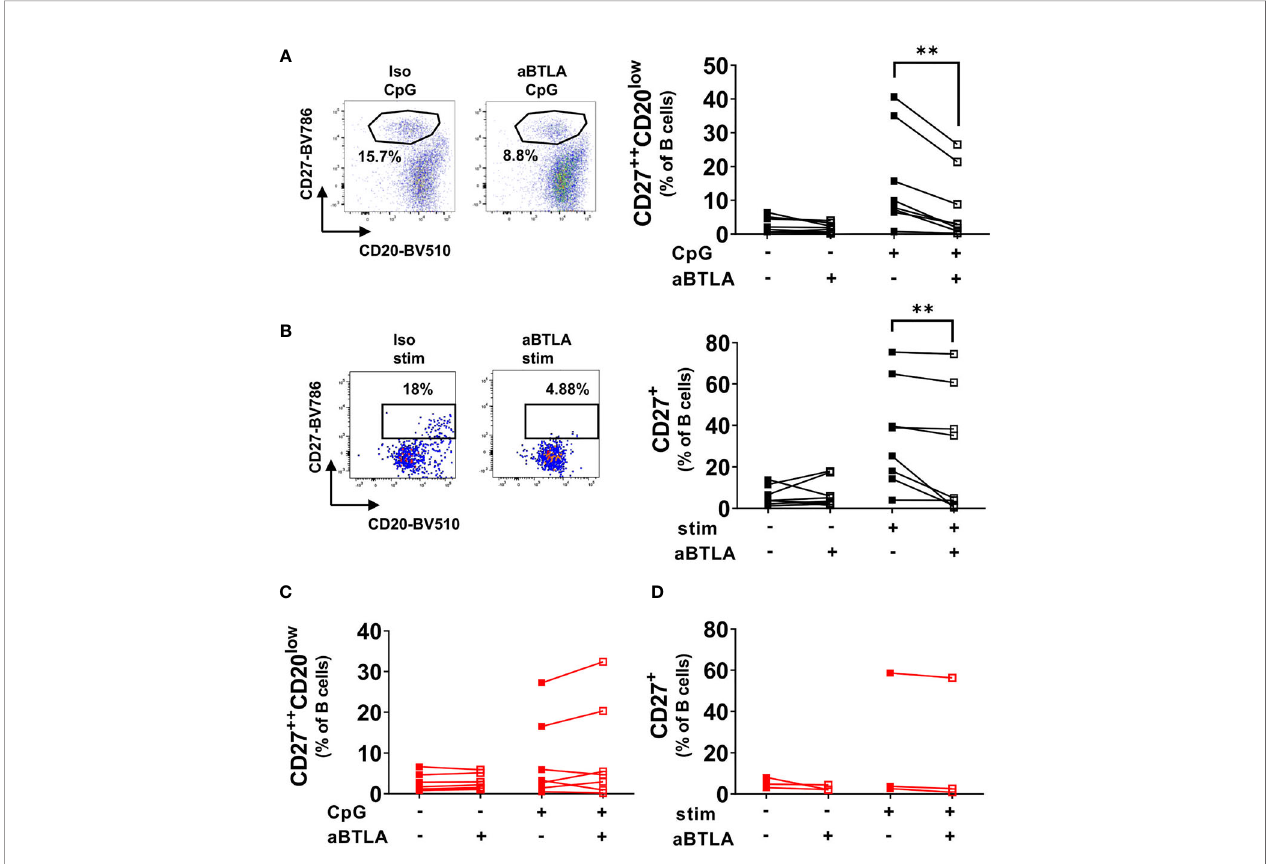
FIGURE 2 | BTLA activation inhibits differentiation of HD B cells but not SLE B cells. (A) HD PBMCs were stimulated with CpG for fi ve days in the presence of an activating anti-BTLA antibody or isotype control. Representative dotplots and cumulative data of plasmablast frequencies among CD19 + CD20 +/- B cells. HD n=8. (B) Sorted CD27-IgD+ naïve HD B cells were stimulated with a combination of IL-2, IL-10, aBCR, CpG and CD40L for fi ve days at 37°C and 5% CO 2 in the presence of an activating anti-BTLA antibody or isotype control. Representative dot plots of CD19 + CD20 +/- B cells and cumulative data of the frequency of CD27 + cells among CD19 + CD20 +/- B cells. HD n=7. (C) SLE PBMCs were stimulated as in A). Representative dot plots of CD19 + CD20 +/- B cells with plasmablast frequencies and cumulative data. n=7. (D) Sorted CD27 - IgD + naïve SLE B cells were stimulated as in B). Representative dot plots of CD19 + CD20 +/- B cells and cumulative data of the frequency of CD27 + cells among CD19 + CD20 +/- B cells. n=3. Statistical signi fi cance was assessed by using Wilcoxon signed rank test. **p <